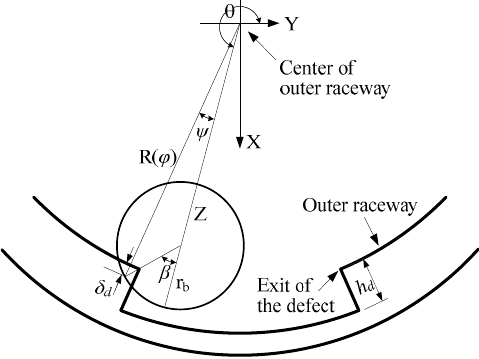
Figure 3. Schematic diagram of the ball passing the spall in the outer raceway.